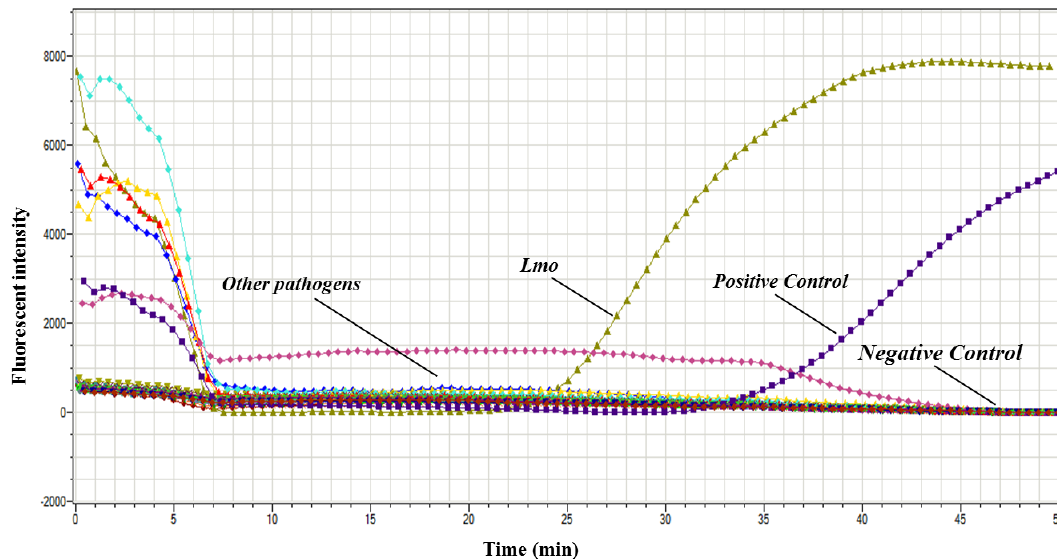
Fig. 4. Speci¯city analysis of the isothermal ampli¯cation assay on the micro°uidic chip.